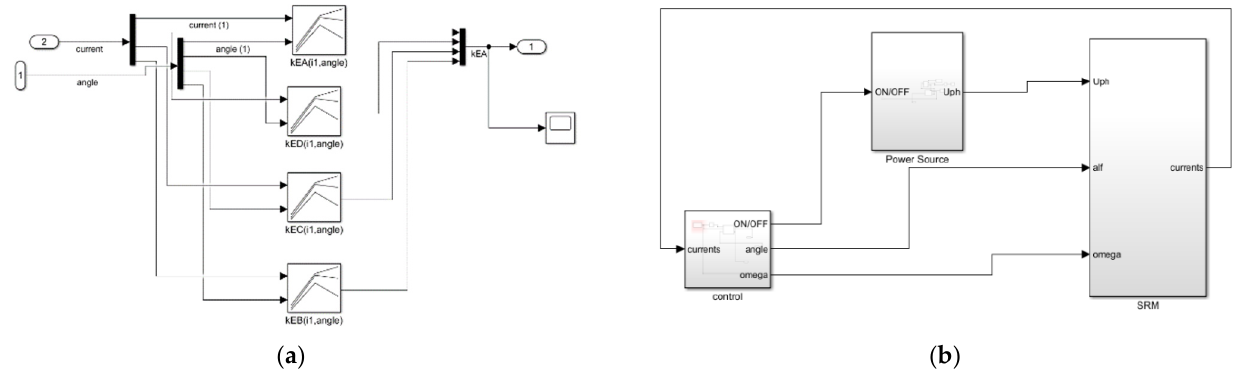
Figure 12. Dynamic SRM modeling in Simulink ( a ) Fragment of Simulink code responsible for loading look-up tables of k e values; ( b ) Simulink model overview of SRM.